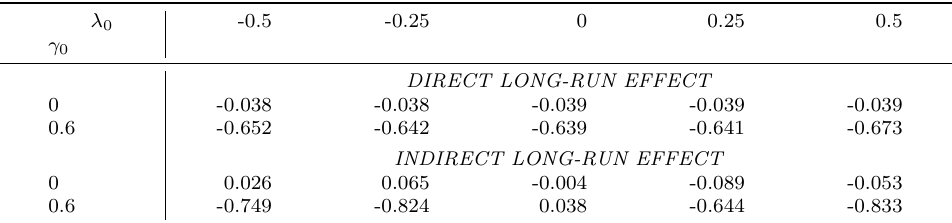
Table 4: Bias of marginal direct and indirect long-run effects of Team Spatial λ 0